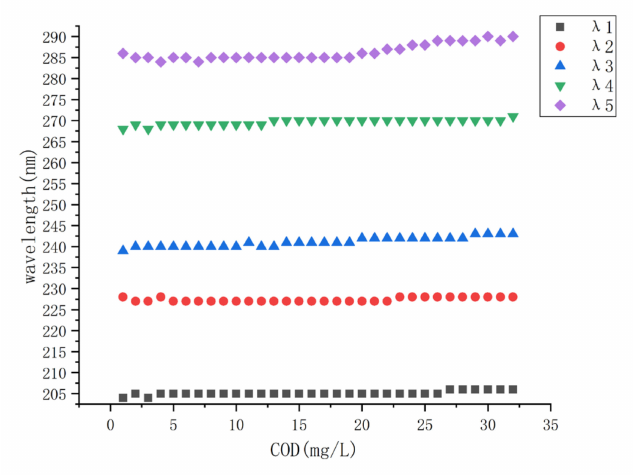
Figure 8. Found by PE in the concentration range of 1~32 mg / L.